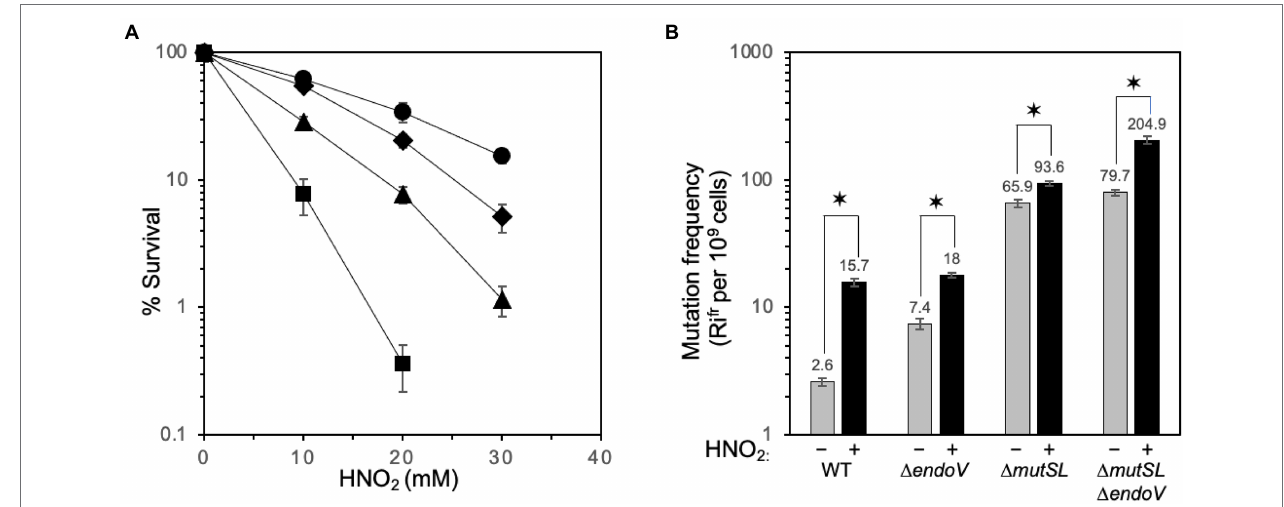
FIGURE 1 | Contribution of MutSL and EndoV in protecting Bacillus subtilis from the cytotoxic and mutagenic effects of spontaneous and HNO 2 -promoted base deamination. (A) Susceptibility of different strains of B. subtilis to nitrous acid. B. subtilis WT ( ● ), mutSL ( ♦ ), endo V ( ▲ ), and mutSL endoV ( ■ ) strains were grown in A3 medium to a OD 600nm of 0.5 and then treated with different doses of nitrous acid (HNO 2 ). The results are expressed as averages ± SD of at least three independent experiments per triplicate. (B) Spontaneous and HNO 2 -induced mutation frequencies of strains with distinct genotypes. The strains indicated were grown at 37 ° C in A3 medium to an OD 600 of 0.5 and then divided into two Erlenmeyer flasks; one of the flasks was left as an untreated control (gray bars), and the other was supplemented with an LD 50 of HNO 2 (black bars). The cultures were shaken for 1 h and after eliminating the deaminating agent from the amended cultures, all the flasks were shaken for an additional period of 12 h at 37 ° C. Finally, all the cultures were processed to calculate the frequencies of mutation to Rif r , as described in Materials and Methods. Each bar represents the mean of data collected from three independent experiments, each performed in sextuplicate, and the error bars represent SEMs. The asterisks indicate values that were significantly different ( * , p <